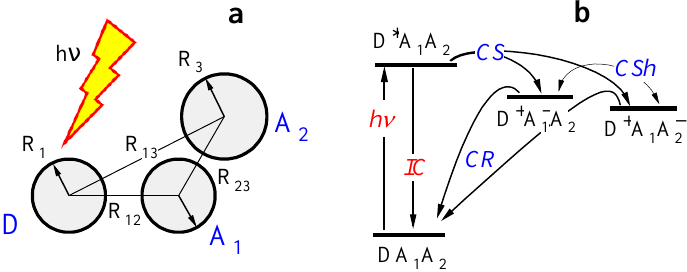
Figure 2. ( a ) Three-center molecular compound of the type DA 1 A 2 , where D is the electron-donating, and A 1 /A 2 are the electron-accepting units. The spatial structure of the compound is shown schemat- ically including the effective radii of the units and the center-to-center distances. ( b ) Photochemical processes in this compound. Abbreviations CS, CR, CSh, and IC denote charge separation, charge recombination, charge shift, and internal conversion,